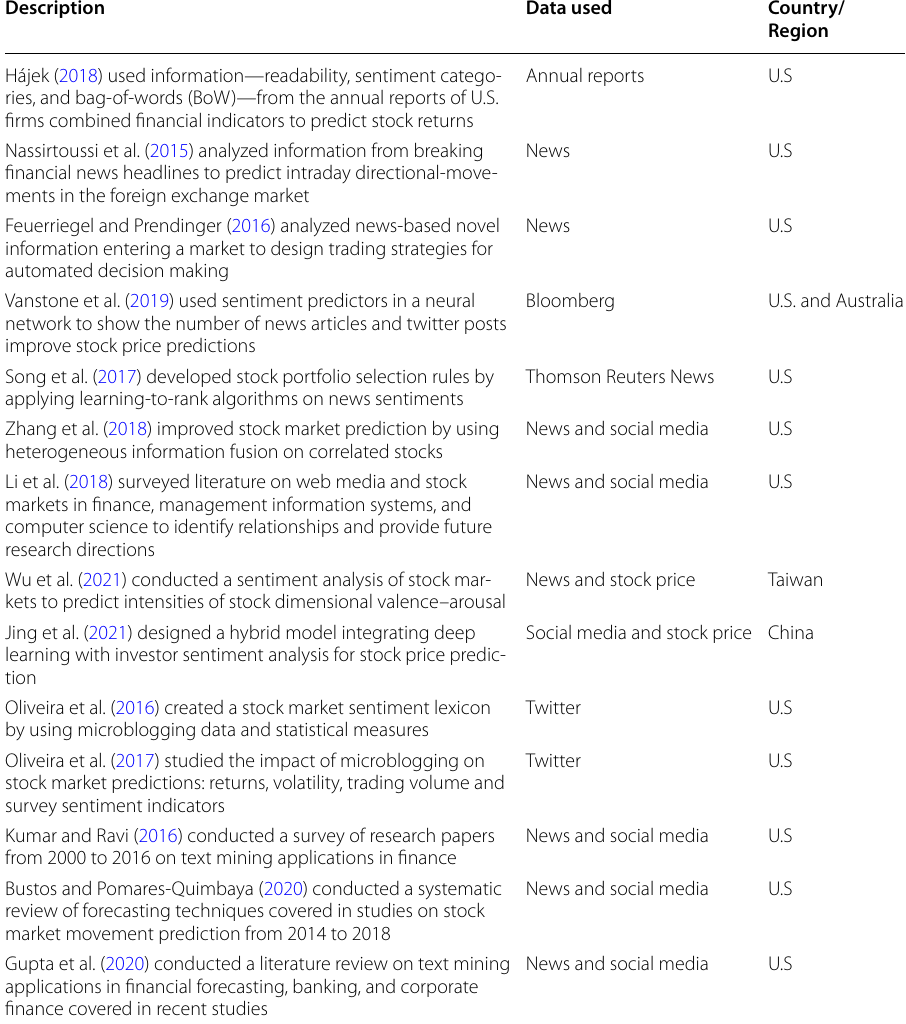
Table 1 Recent articles using text mining for stock market prediction Description Data used Country/